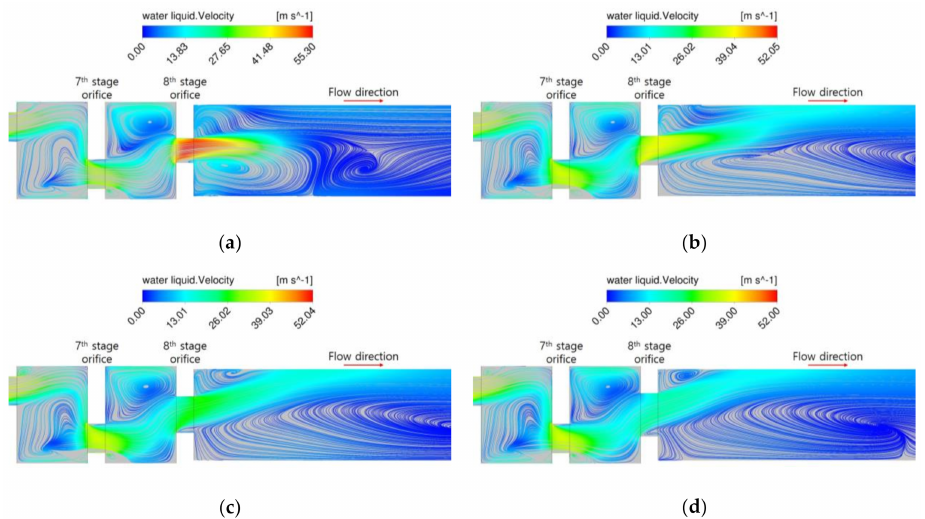
Figure 20. Distribution of flow velocity and streamlines in the second half of the multi-stage orifice (for the symmetric y-z plane) depending on the size of the hole diameter (d 8 ) in the eighth orifice